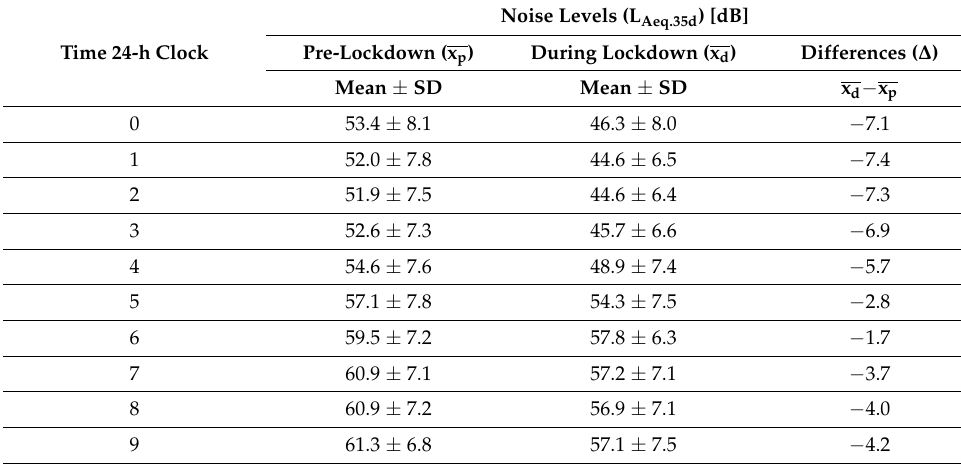
Figure 5. Development of hourly noise levels pre- and during lockdown, overall. Mean L Aeq,1h and standard deviation for all 22 devices. Note that time of day in this figure starts at 12:00 a.m. to better show the distinct decrease between 8:00 p.m. and 1:00 a.m. Table 2. Overall mean hourly noise levels and changes pre- and during